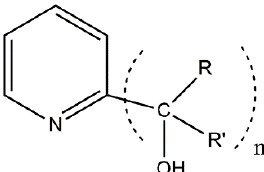
Figure 17. The general formula of the neutral 2-pyridyl alcohols; n can be 1 or 2, while R, R’ are H and various non-donor organic groups (Me, Ph, …).